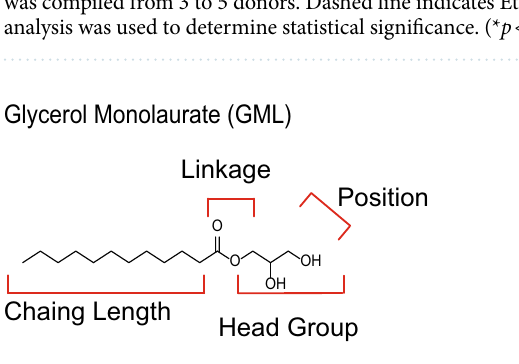
Figure 7. 12-Carbon chain length, a polar head group, and oxygen linkage is required for the ability of GML to suppress T cell function. Carbon chain length of at least 12 carbons is required for GML inhibition of T cell activation. A polar head group and carbonyl linkage is necessary for disrupting membrane dynamics, protein clustering, and calcium signaling. Position of the laurate group does not affect GML activity, as 2-monolaurin is just as effective as GML at inhibiting T cell activity in all functional assays. However, more than a single laurate group causes the compound to become inactive and no longer suppress T cell